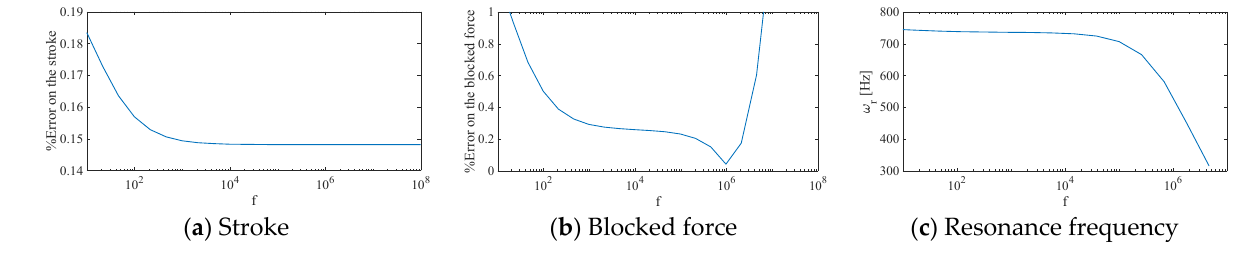
Figure 4. Influence of the fictitious finite element factor f.